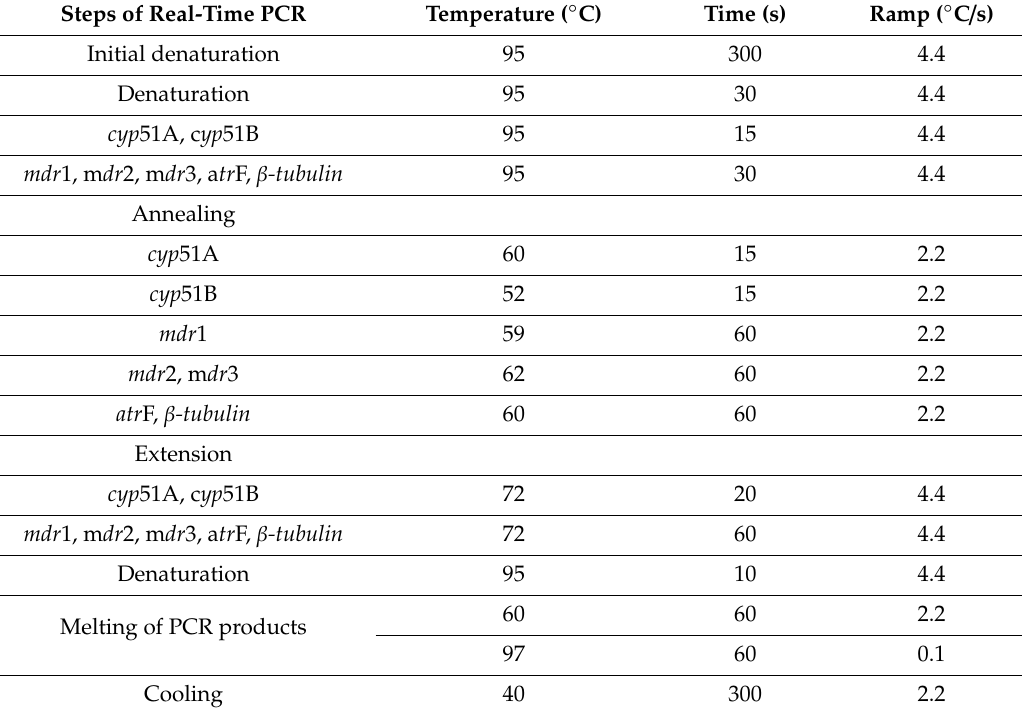
Table 3. Time and temperature profile of all genes tested in real-time